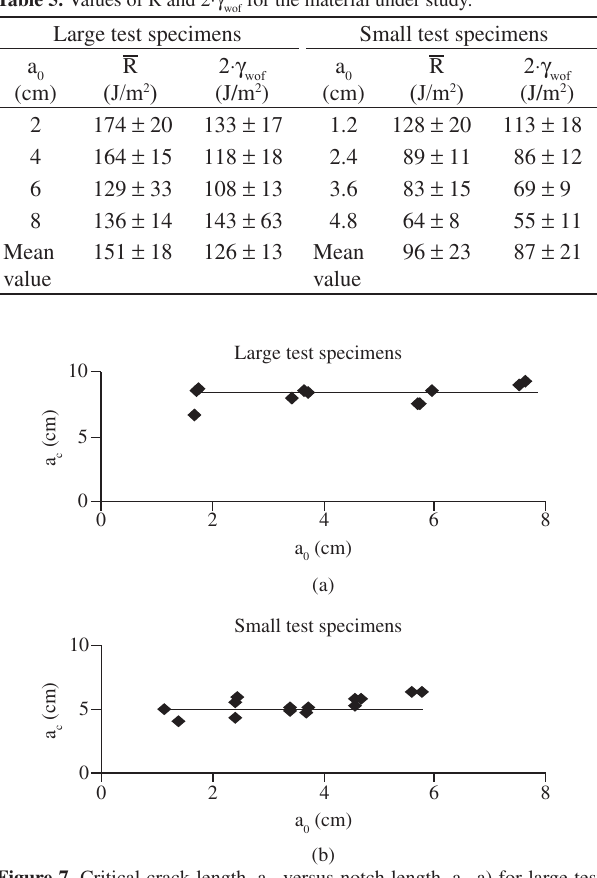
, versus notch length, a c